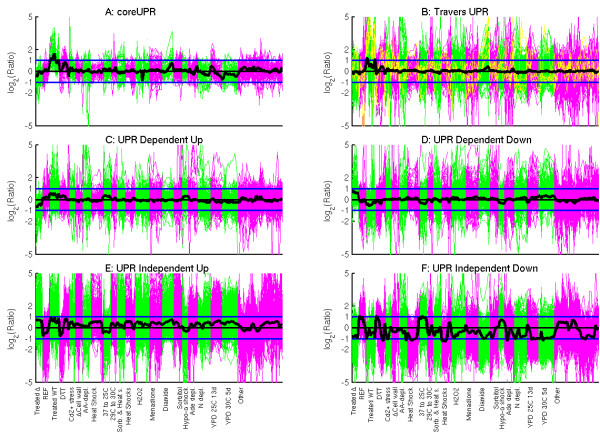
Expression of secretion stress related genes of S. cerevisiae under different stress conditions. Expression values of the genes (shown as log2 of the expression level ratio in stress vs. reference conditions) from 174 different stress conditions were collected from published articles. The expression level values of individual genes are shown in purpleor greenand the median of the gene group in blackand the standard deviation of the whole experiment in blue. A: "coreUPR", genes showing significant up regulation in "Treated WT" experiment set against both the "Treated ρ" and "REF" experiment sets. B: "Travers UPR", genes defined as UPR genes and genes defined as UPR model genes in yellowby [2]. C: "UPR Dependent Up", genes showing significant up regulation only in "Treated WT" set against "Treated ρ" set. D: "UPR Dependent Down", genes showing significant down regulation only in "Treated WT" against "Treated ρ" set. E: "UPR Independent Up", genes showing significant up regulation only in "Treated WT" against "REF" set. F: "UPR Independent Down", genes showing significant down regulation only in "Treated WT" against "REF" set. The stress conditions were divided in sets as follows: Treated ρ IRE1 and HAC1 deletion strains treated with DTT or tunicamycin, used as UPR dependent reference set in this study [2, 3]; REF reference set, used as UPR independent reference in this study [17, 18]; Treated WT cultures treated with DTT or tunicamycin or recombinant strains producing a secreted heterologous protein, used as UPR conditions in this study [2, 3, 17-19, 69]; DTT DTT treatment, 4 h time series [17]; Cd2+ stress Cd2+ treatment, 2 h time series and met4 deletion [48]; ρCell Wall strains deleted in cell wall genes [49]; AA-depl. methyl methanesulfonate, 3-aminotriazole and amino acid depletion treatments and GCN4 constitutive and GCN4 deletion strains [35]; Heat Shock 1 h time series after heat shock from 25°C to 37°C, [17]; 37 to 25 1, 5 h time series after temperature shift from 37°C to 25°C, [17]; 29C to 33C 1, 5 h time series after mild heat shock of 29°C to 33°C [17]; Sorbi. & Heat S. mild heat shock with different osmolarities, like previous but with sorbitol treatments [17]; Heat Shocks different heat shocks [17]; H202 2 h time series after hydrogen peroxide treatment [17]; Menadione 2 h time series after menadione treatment [17]; Diamide 1, 5 h time series after diamide treatment [17]; Sorbitol 2 h time series after hyper-osmotic shock with sorbitol [17]; Hypo-o shock 1 h time series after hypo-osmotic shock with sorbitol [17]; Ade. depl. 6 h time series after amino acid and adenine depletion [17]; N depl. 3 d time series after nitrogen depletion [17]; YPD 25C 13 d 13 d time series of growth on YPD at 25°C [17]; YPD 30C 5 d 5 d time series of growth on YPD at 30°C [17]; Other other conditions [17].